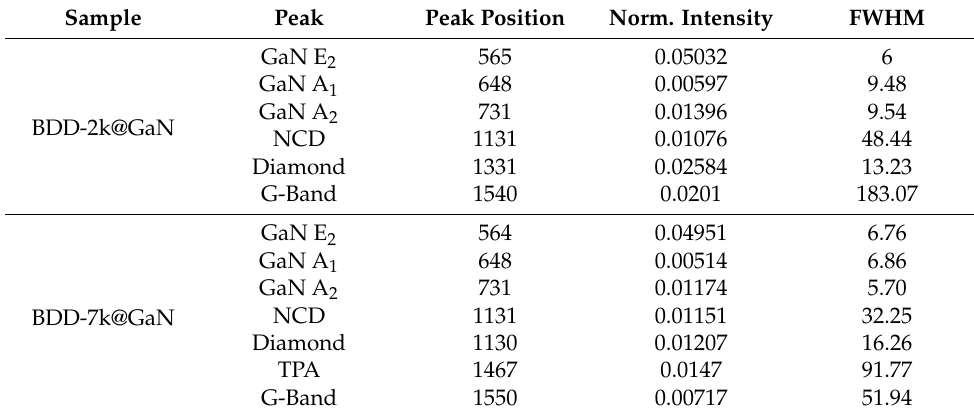
Figure 4. Normalised Raman spectra modelled using the Breit-Wigner-Fano function: ( a , b ) BDD2k and ( c , d ) BDD7k. Raman spectroscopy can also reveal induced stress in the GaN film. The final stress in the GaN depends on the conditions of the diamond deposition process, such as the